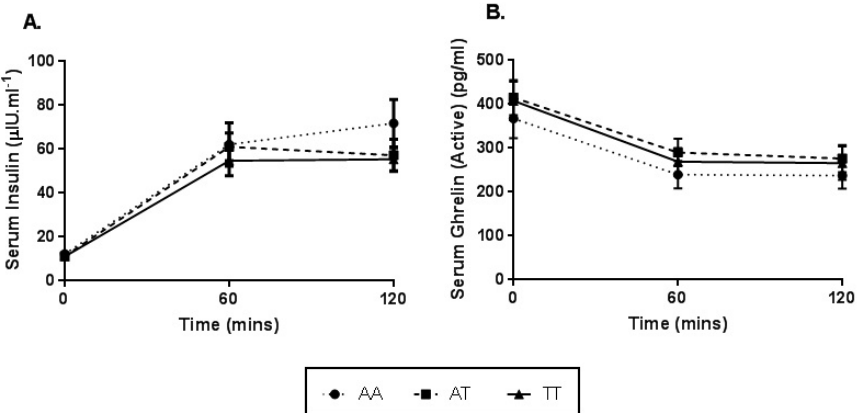
Figure 3. Serum insulin ( A ) and ghrelin ( B ) concentrations observed prior to and following an OGL challenge between genotypes for the FTO rs9939609 polymorphism. Values expressed as mean ± SEM. A main e ff ect for time was observed in A and B response to an OGL, p < 0.001.